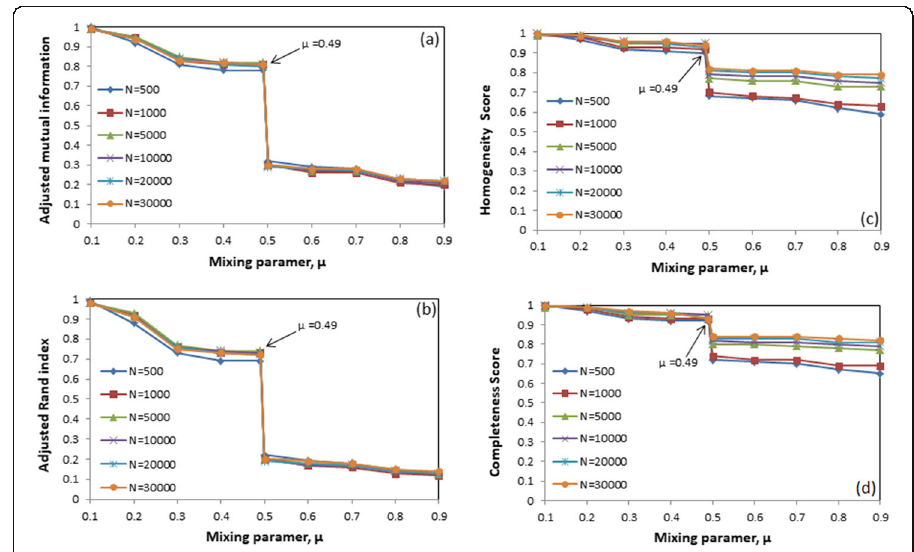
Fig. 2 Variation of ( a ) the adjusted mutual information (AMI), b adjusted Rand index (ARI), c homogeneity score (HS) and ( d ) completeness score (CS) with mixing parameter, μ for network sizes between 500 and